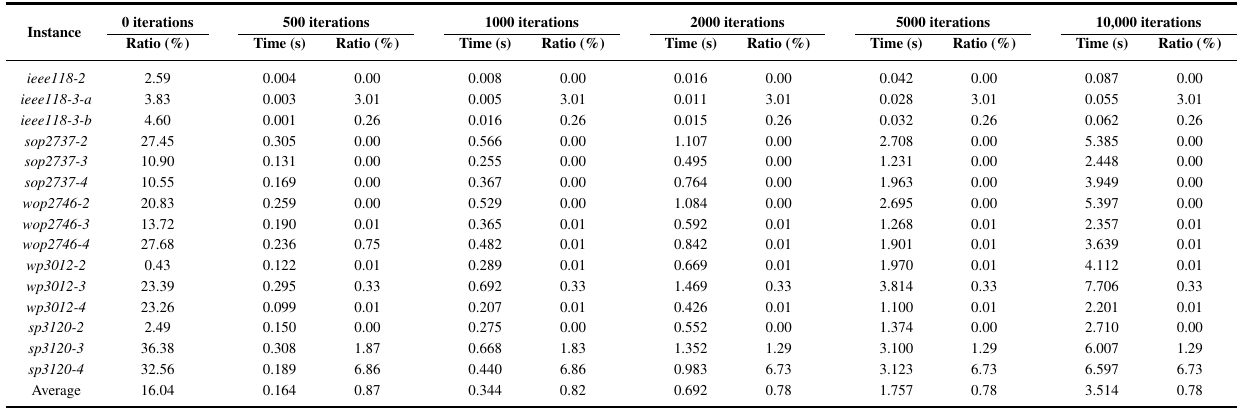
Table 2. Computational results generated by the tabu search algorithm with L = 7 .